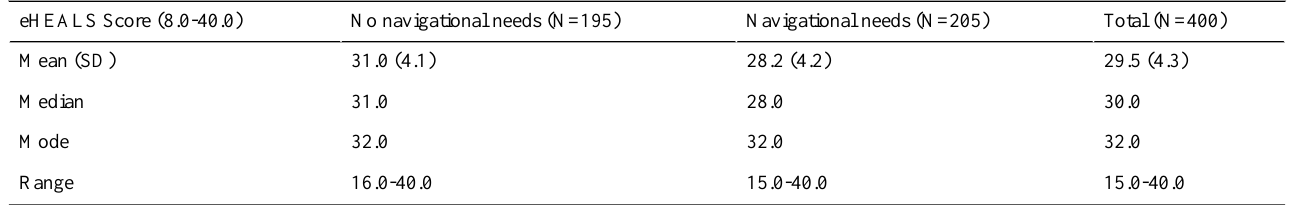
Table 6. Summary statistics: eHEALS scores.